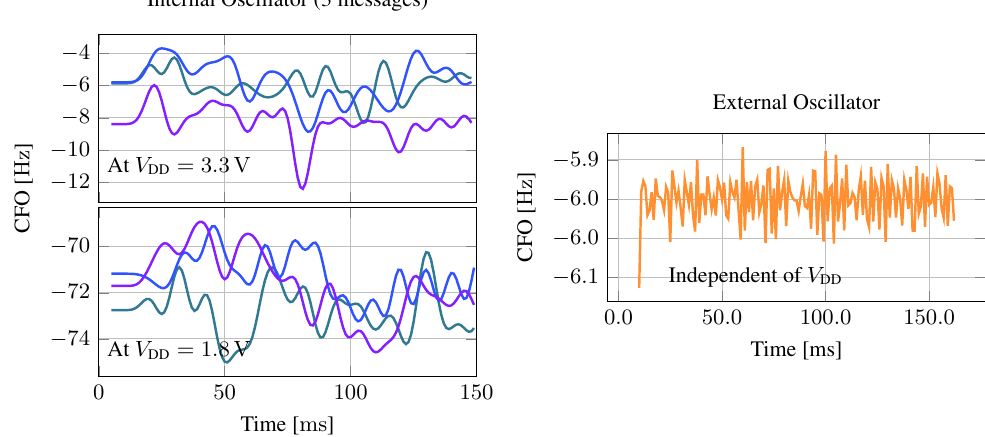
Figure 11. Carrier frequency offset measured throughout three consecutive messages (differently colored lines). The supply voltage level strongly influences the generated carrier frequency when using the internal oscillator, but it also fluctuates significantly during the message. The external oscillator is independent of the supply voltage and much more